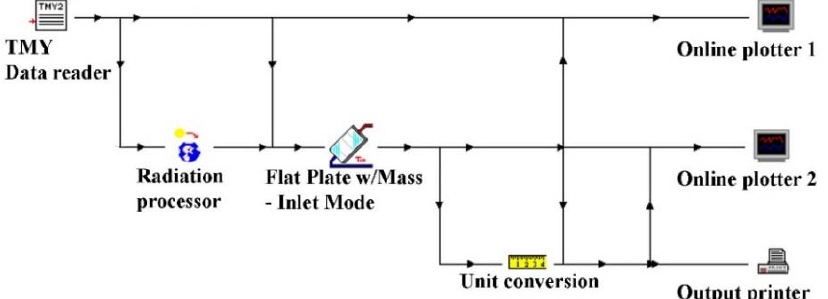
Figure 11. Calculation logical diagram introduced in TRNSYS for the simulation of the solar collectors operation.